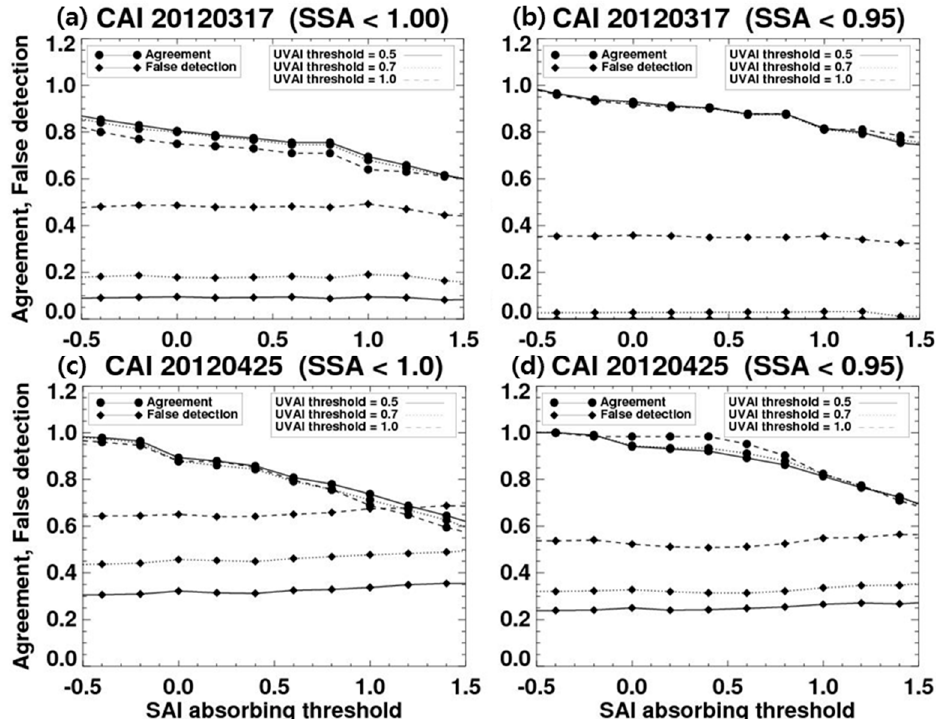
Figure 10. ( a – d ) Results of an agreement and false detection test of OMI UVAI and TANSO-CAI SAI for 17 March and 25 April 2012, respectively. The left column shows the results for OMI SSA values less than 1.0, while the right column shows the results for SSA values less than 0.95. The SAI value of 0.5 corresponds to a UVAI value of 0.7. The false detection rate is constant for moderate absorbing aerosol cases.